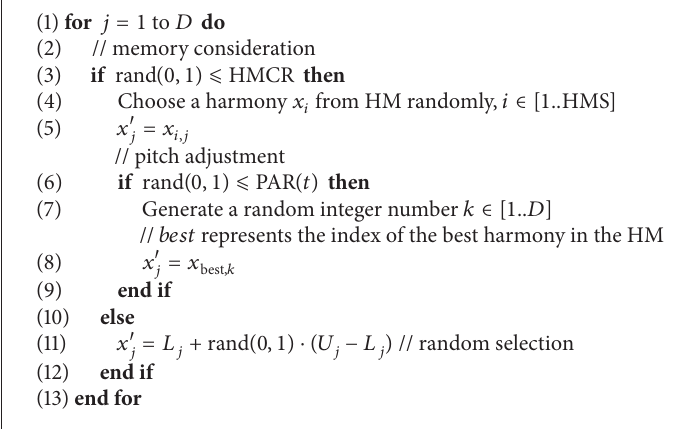
Algorithm 2: The procedure of improvising a new harmony of